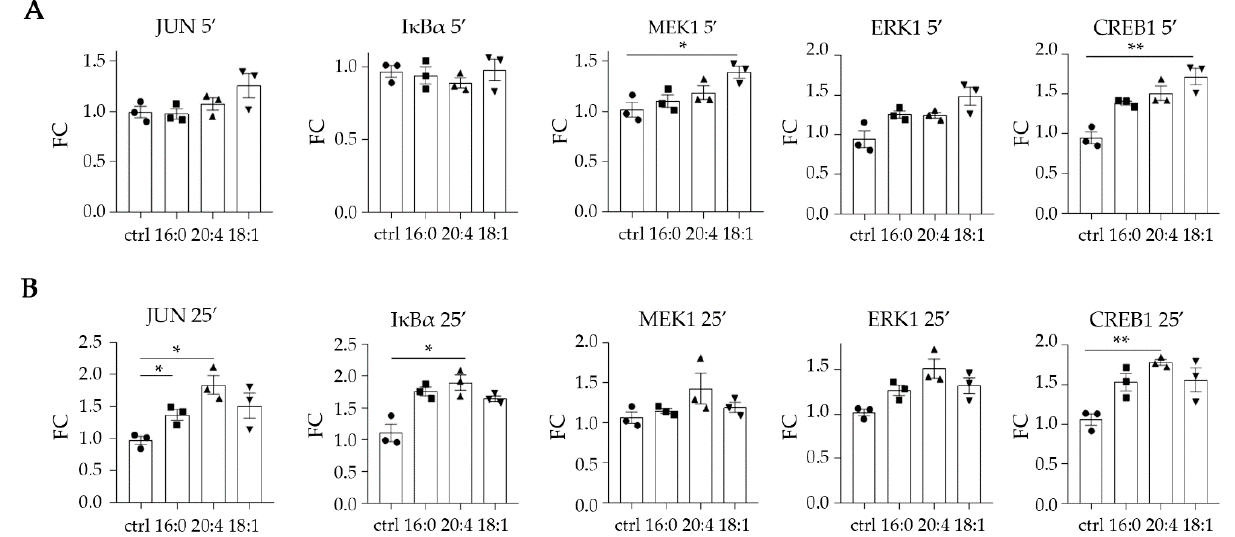
Figure 5. LPA stimulates the phosphorylation of JUN, I κ B α , MEK1, ERK1, and CREB1 in human kidney proximal tubular epithelial cells (HKC-8). Cells were incubated with three different LPA species (16:0, 20:4, 18:1) at 10 µ M for 5 ( A ) or 25 min ( B ), and the phosphorylation was assessed with multiplex ELISA in triplicates. Circles correspond to control values, squares correspond to LPA 16:0 values, upward triangles correspond to LPA 20:4 values and downward triangles correspond to LPA 18:1 values. Statistical significance was assessed with Brown–Forsythe’s and Welch’s ANOVA followed by Dunnett’s post hoc test in the case of normal distribution or with Kruskal–Wallis test in the case of non-normal distribution. * p < 0.05, ** p < 0.01.